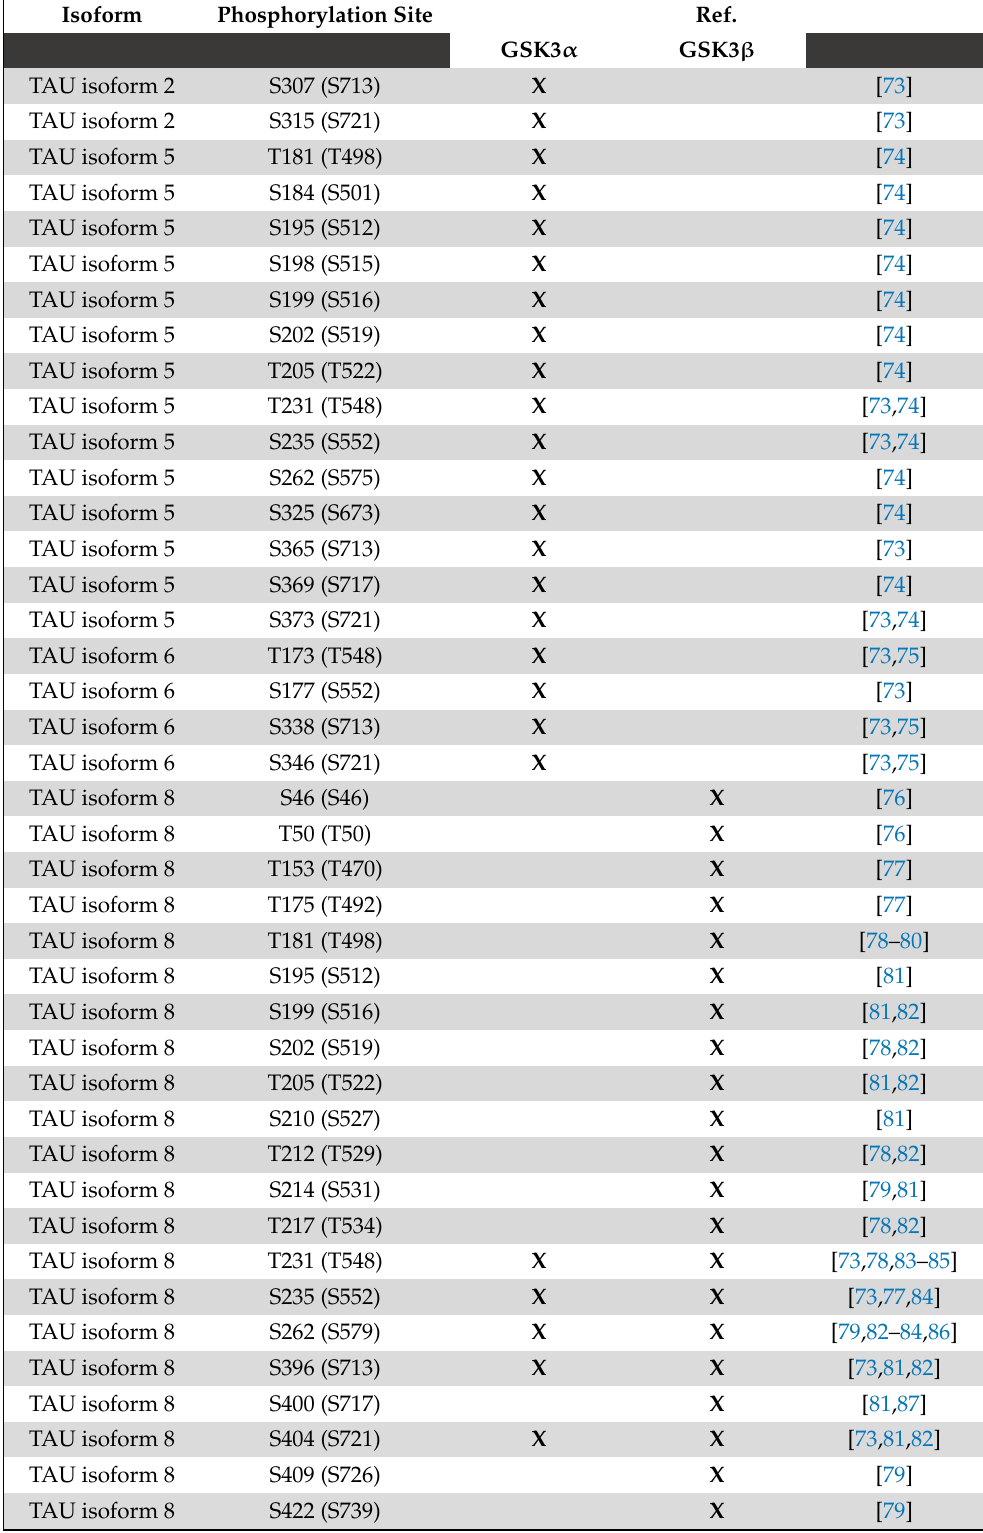
Table 3. Sites of GSK3 α / β -mediated phosphorylation in TAU